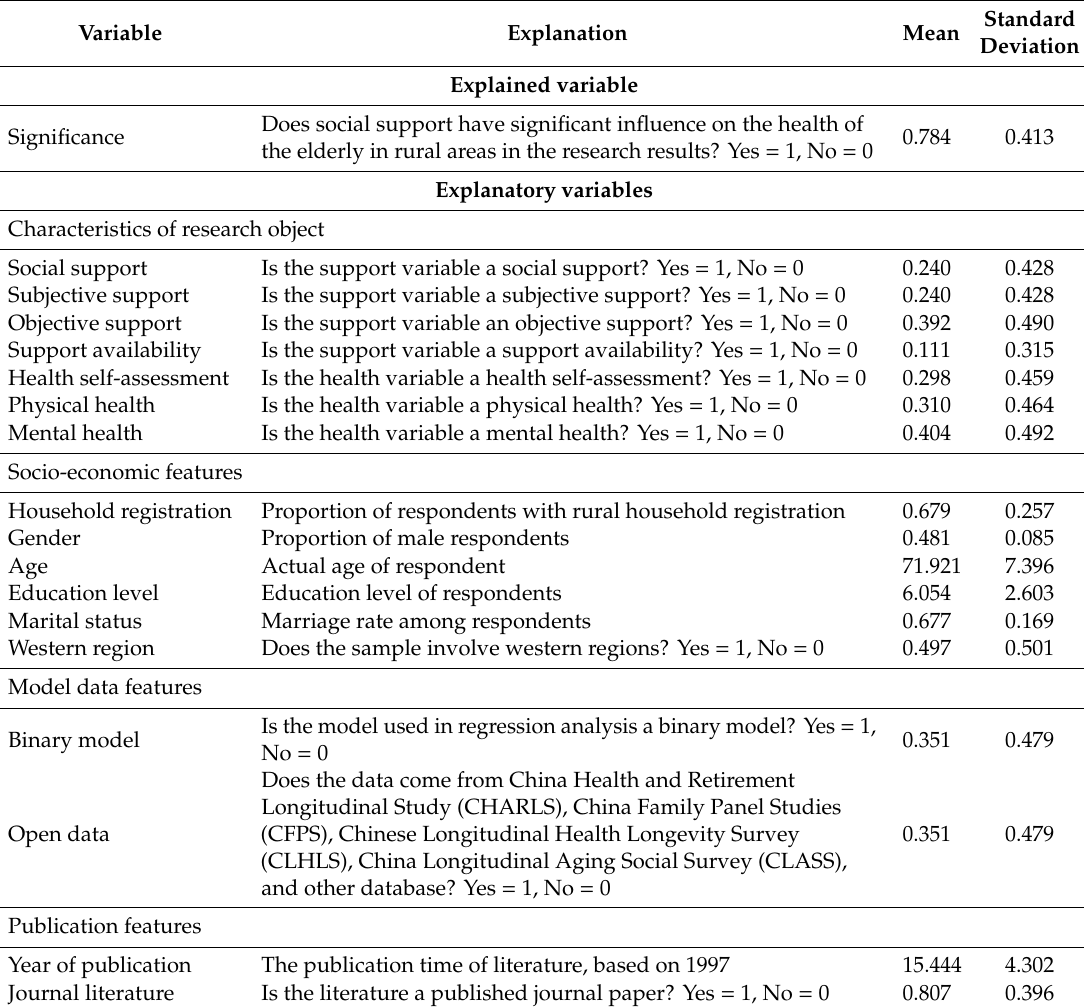
Table 2. Variable definition and descriptive